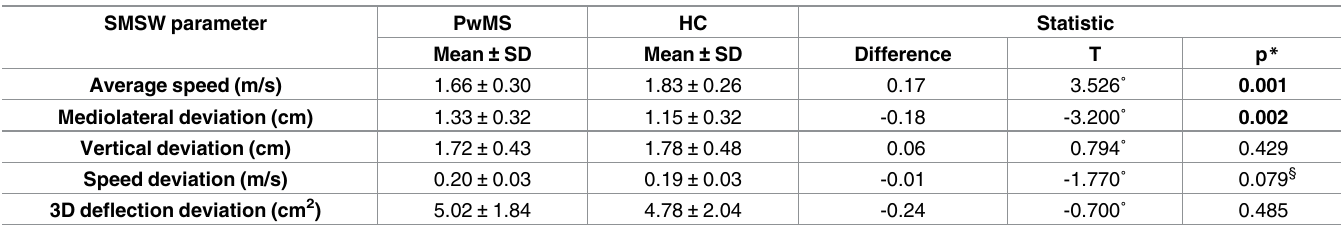
Table 3. Group differences between PwMS and HC.